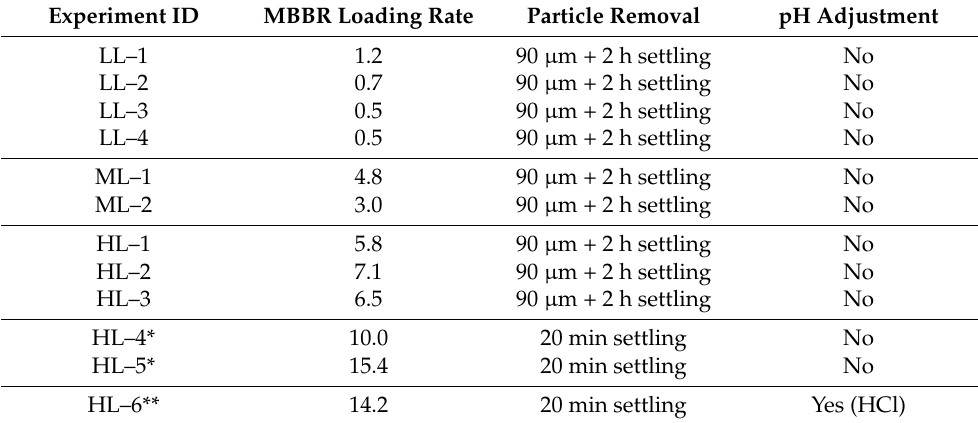
Table 1. Applied Pre-Treatment for FO Experiments.